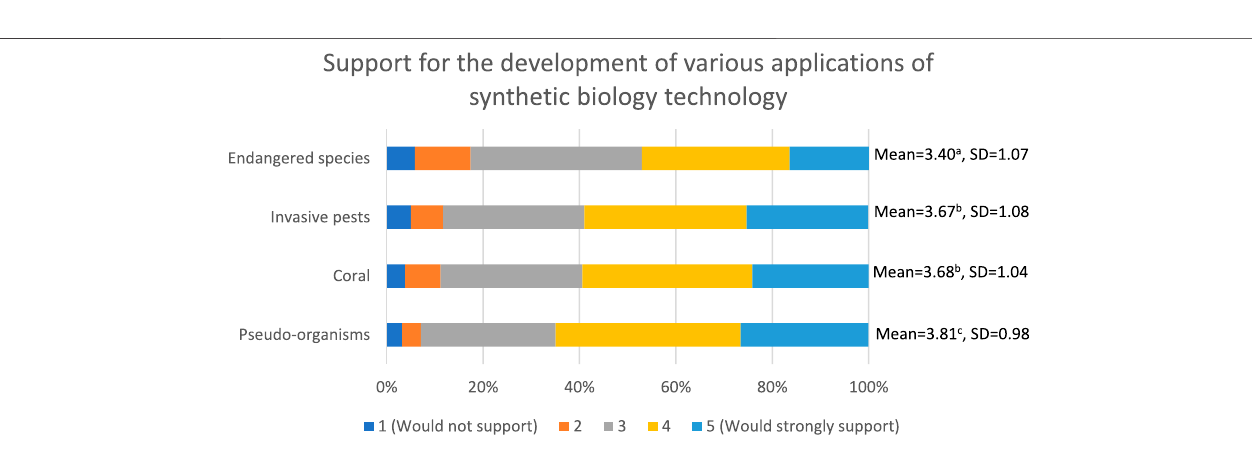
Frontiers in Environmental Science |